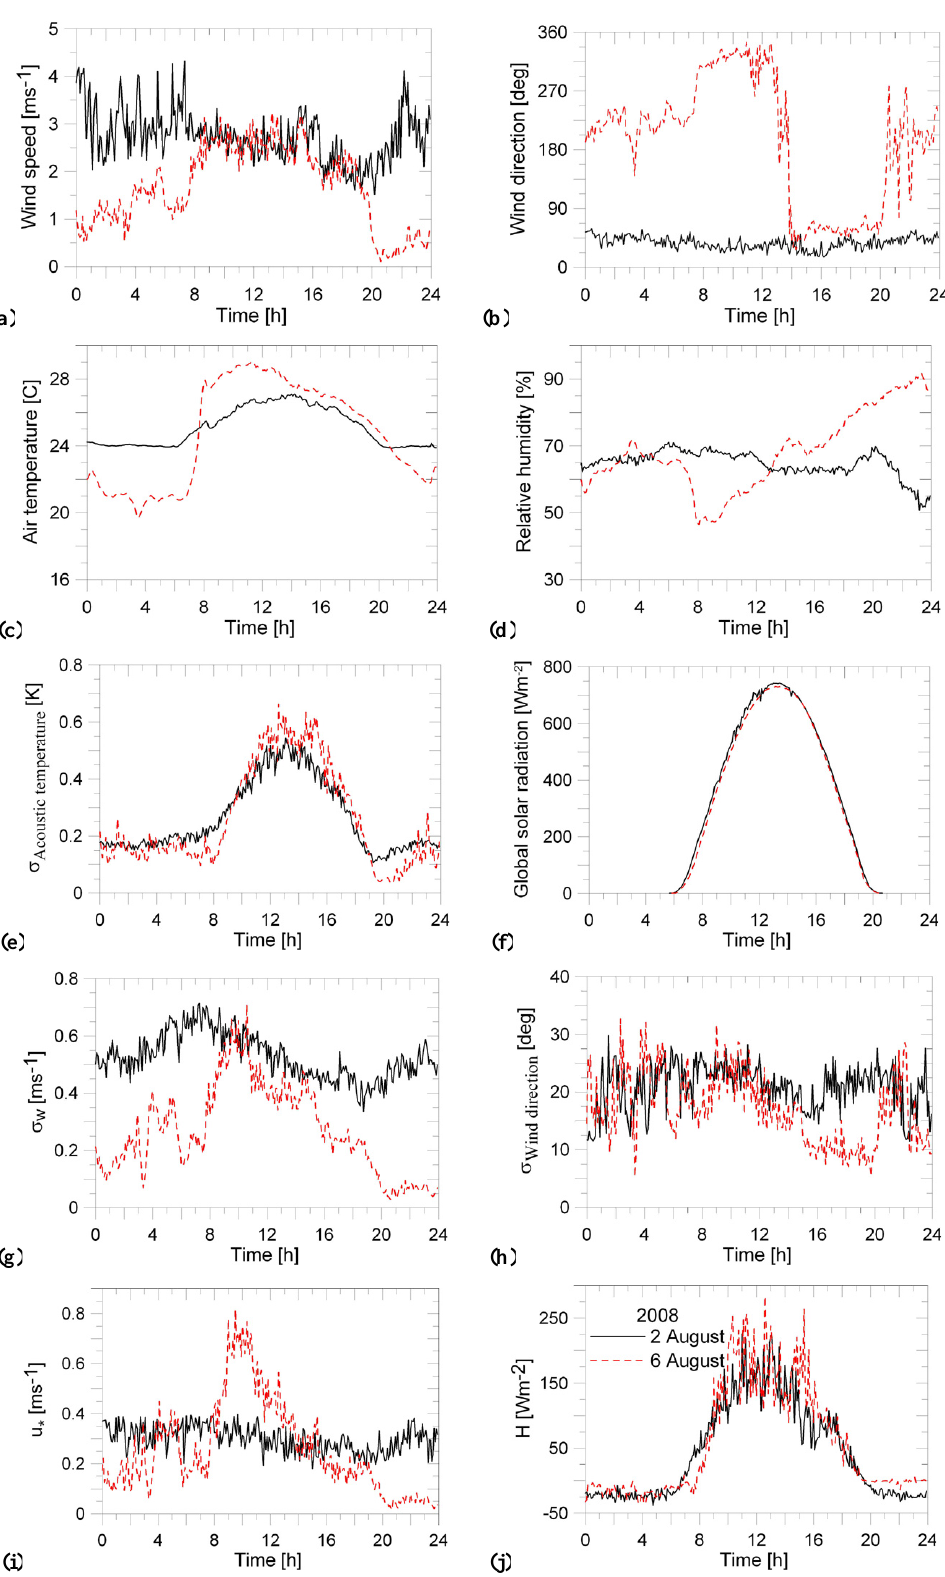
Figure 3. Horizontal wind speed (a) ; wind direction (b) ; air temperature (c) ; relative humidity (d) ; standard deviation of acoustic temperature (e) ; global solar radiation (f) ; standard deviation for the vertical wind speed (g) ; standard deviation for the wind direction (h) ; friction velocity (i) ; and sensible heat flux (j) on 2 August 2008 (black solid lines) and on 6 August (red dashed lines) at MO Ahtopol. Five-minute averaged